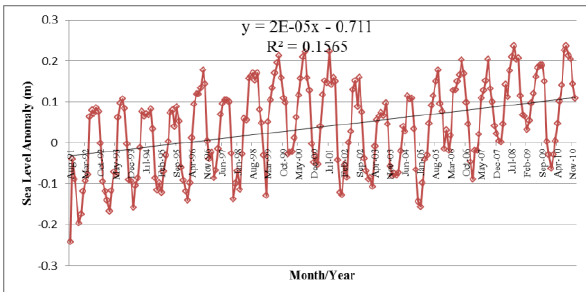
Figure 6. Monthly sea level anomaly averages obtained from merged altimetry missions from 1991 to 2010. The monthly records indicate a rising trends in sea level.